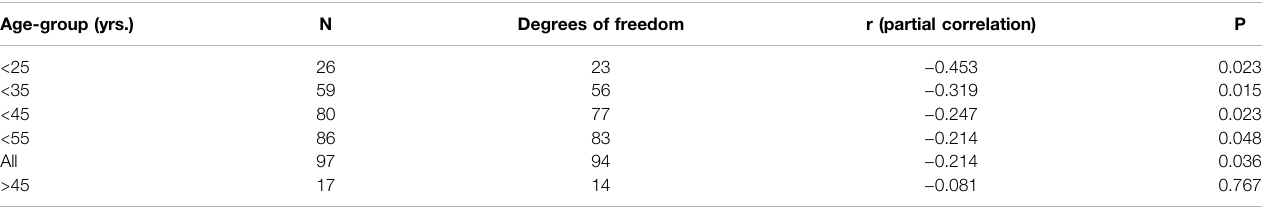
TABLE 1 | Partial correlations of DOC vs. sesonality in cumulative age groups. Age-group (yrs.)